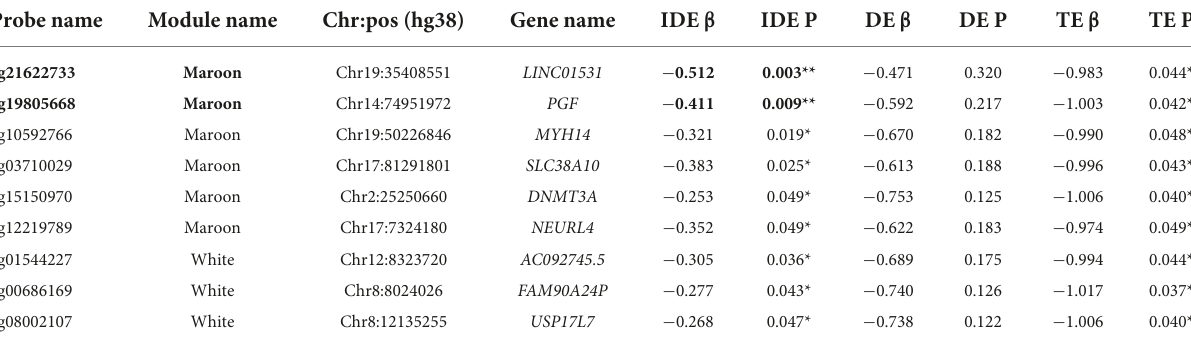
TABLE 4 Probe-wise mediation analysis of the relationship between childhood trauma burden (CTQ total) and rostral middle frontal gyrus (RMFG) surface area